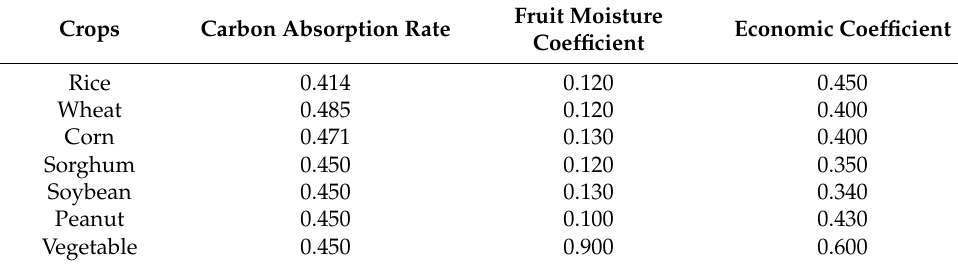
Table 3. Carbon absorption coefficient of